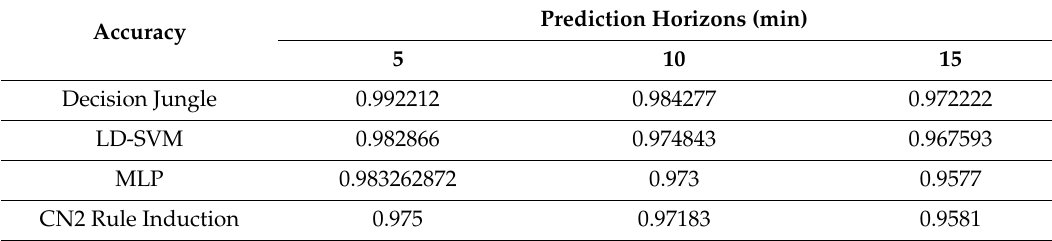
Table 5. Accuracy for di ff erent models